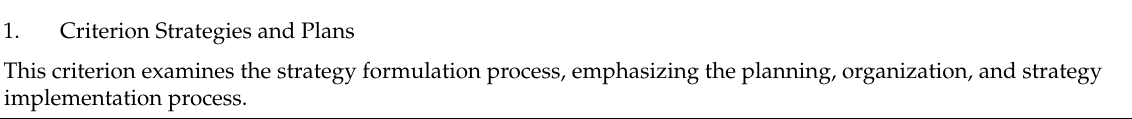
Table A1. Criteria and indicators that make up Migg Vegetable